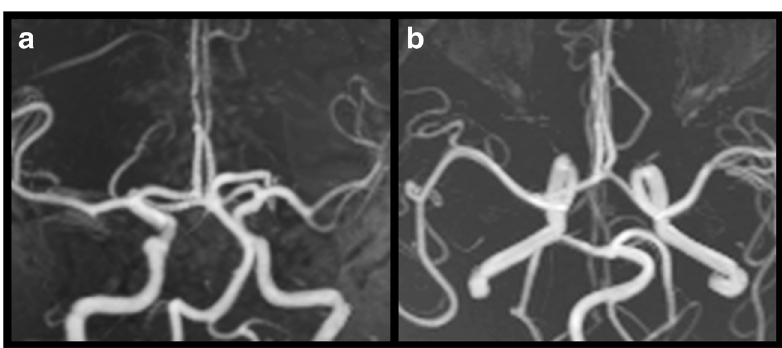
Fig. 3 Maximum intensity projection of an intracranial three- dimensional time-of-flight MR angiography sequence acquired in a 52-year-old man with Fabry disease. Coronal ( a ) and axial ( b ) reconstructions showthepresence of a mild elongation and tortuosi- ty of the posterior